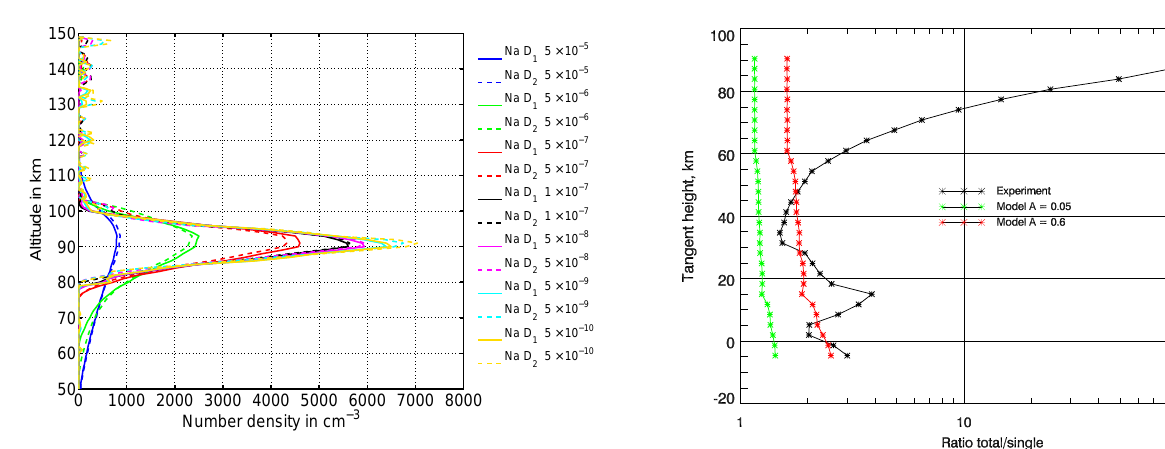
Figure 9. Measured radiance to single scattering ratio (averaged be- tween 649 and 661nm, see Fig. 10) for different tangent altitudes of a series of nominal limb measurements as well as total to single scattering ratio for different ground albedos simulated with SCIA-